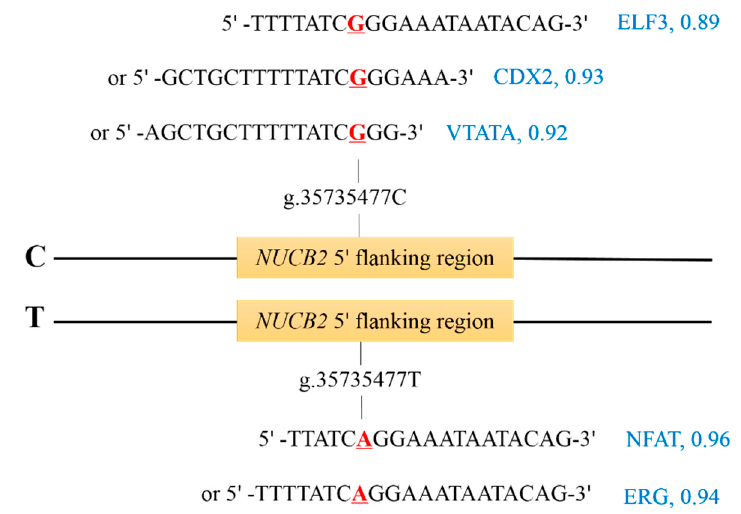
Figure 3. Transcription factor binding sites (TFBSs) in the 5 ′ flanking region of NUCB2 gene. The nucleotides represent the transcription factor binding site sequences of ETS transcription factor 3 (ELF3), caudal type homeobox 2 (CDX2), mammalian C-type LTR TATA box (VTATA), nuclear factor of activated T-cells (NFAT), and v-ets erythroblastosis virus E26 oncogene homolog (ERG) with their matrix similarity over 0.85 (in blue), and the underlined nucleotide in red was the SNP.